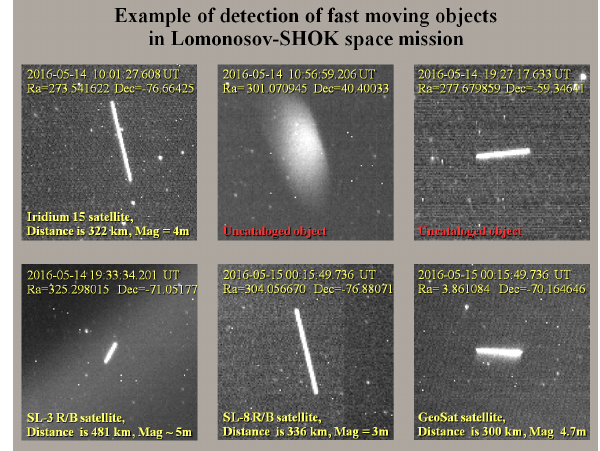
Figure 3. Examples of identification of fast moving objects with the use of wide field cameras on-board Lomonosov